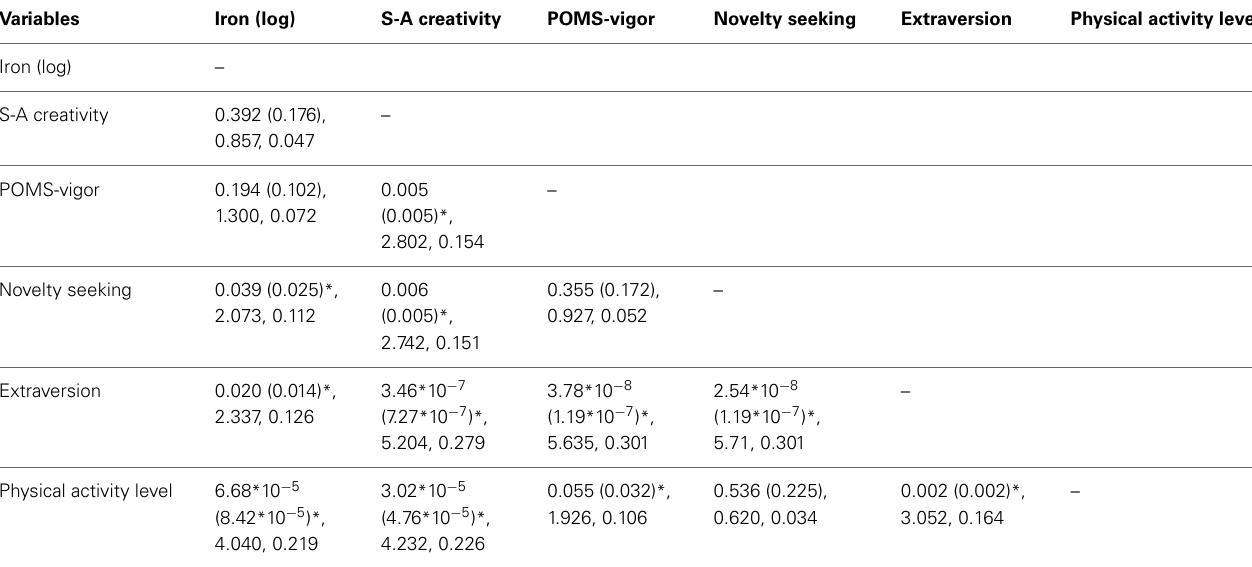
Table 2 | Statistical values from the multiple regression analyses comparing mineral levels and cognitive functions.